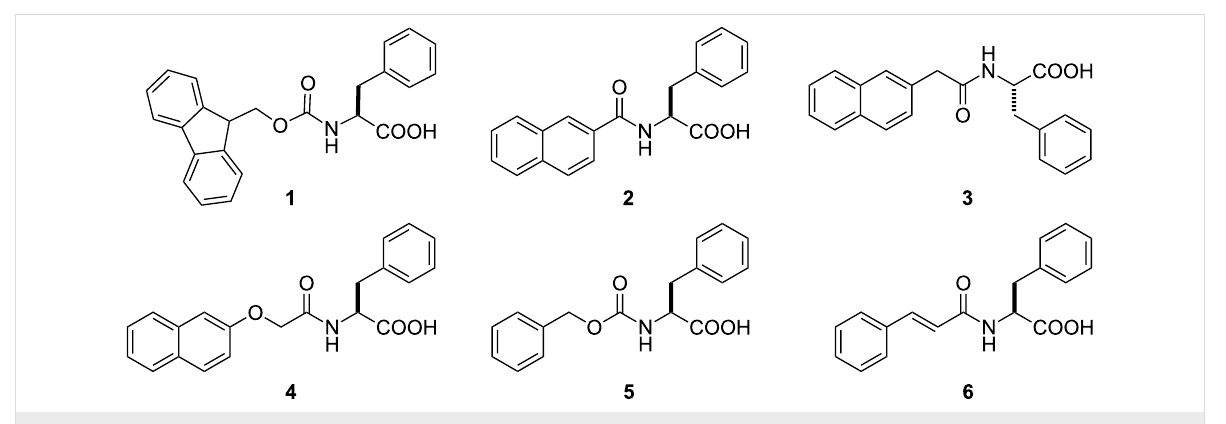
Scheme 1: The chemical structures of the phenylalanine derivatives.